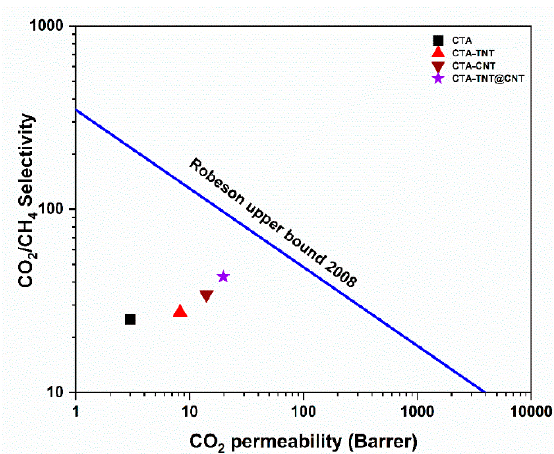
Figure 9. Plot of CO 2 /CH 4 separation efficiency of the synthesized membranes compared to the Robeson upper-bound plot [93].